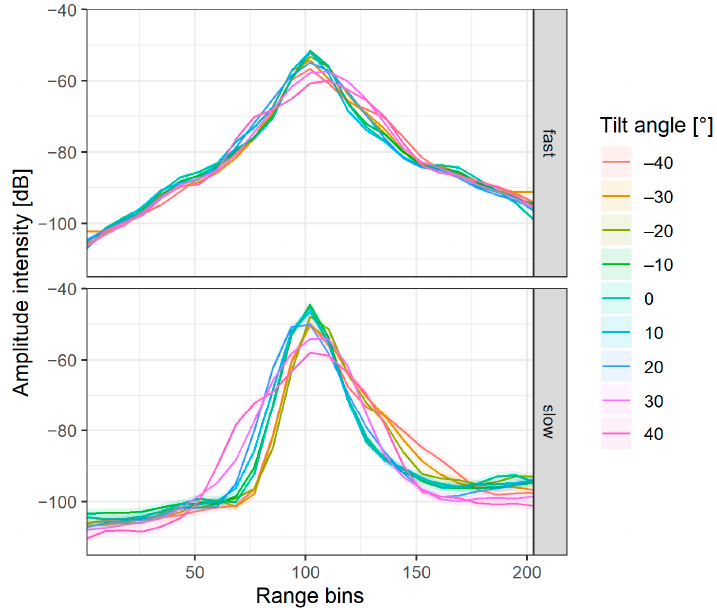
Figure 3. Amplitude echo envelopes modeled using the generalized additive mixed model M1 for given individual tilt angles (0° correlates to the true dorsal aspect; negative angles correlate to the head tilted toward the transducer; positive angles correlate to the tail tilted toward the transducer) in fast- or slow-tapered acoustic pulses. Individual curves correspond to the plot of s angle profile ( a , t ) for given angle a .